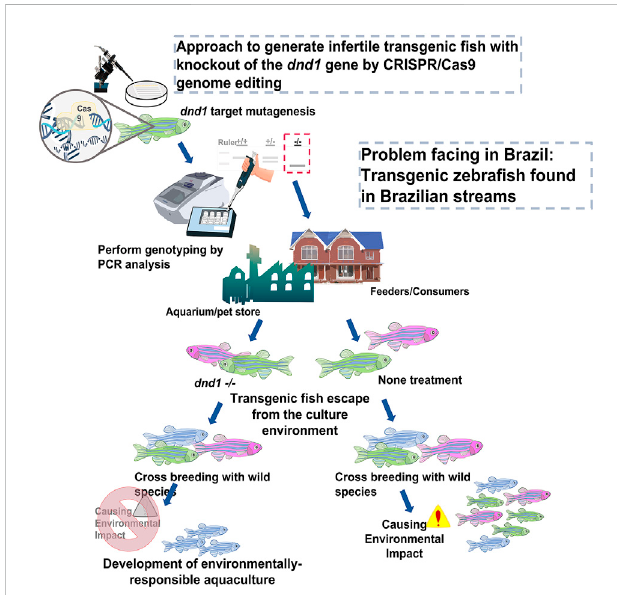
FIGURE 9 Approach to generate infertile transgenic fl uorescent zebra fi sh with knockout out of the dnd1 gene by CRISPR/Cas9 genome editing. We demonstrate that the dnd1 knockout by CRISPR/Cas9 genome editing could be applied to the infertility control of transgenic fl uorescent zebra fi sh to prevent them from cross-breeding with wild species when they escape into the wild fi eld. It can promote the development of an environmentally responsible